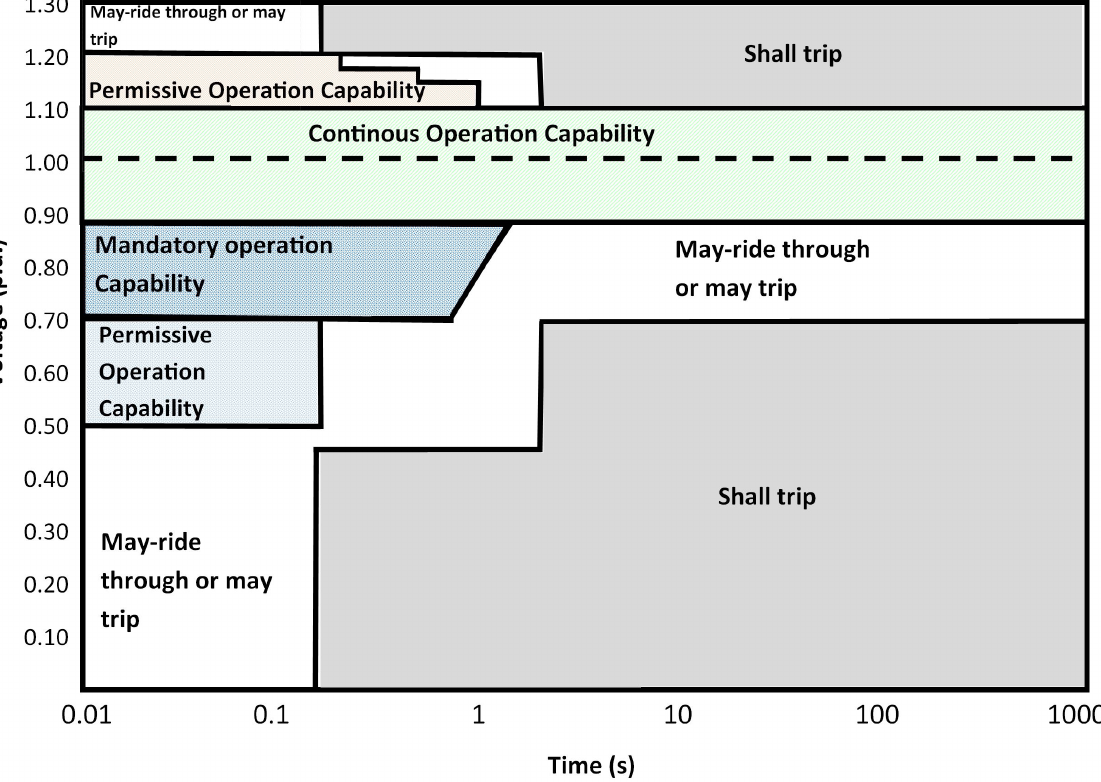
Figure 7. Allowed voltage levels, adapted from